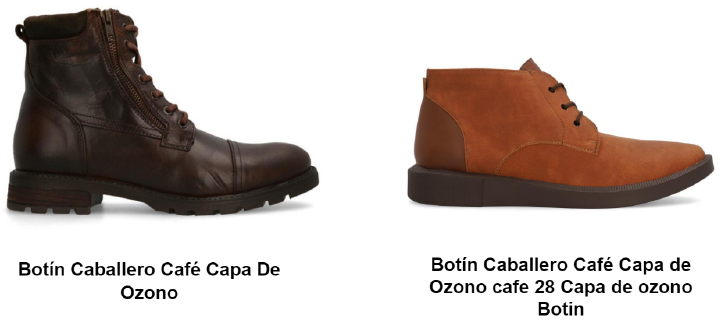
Figure A8. Different products with almost identical